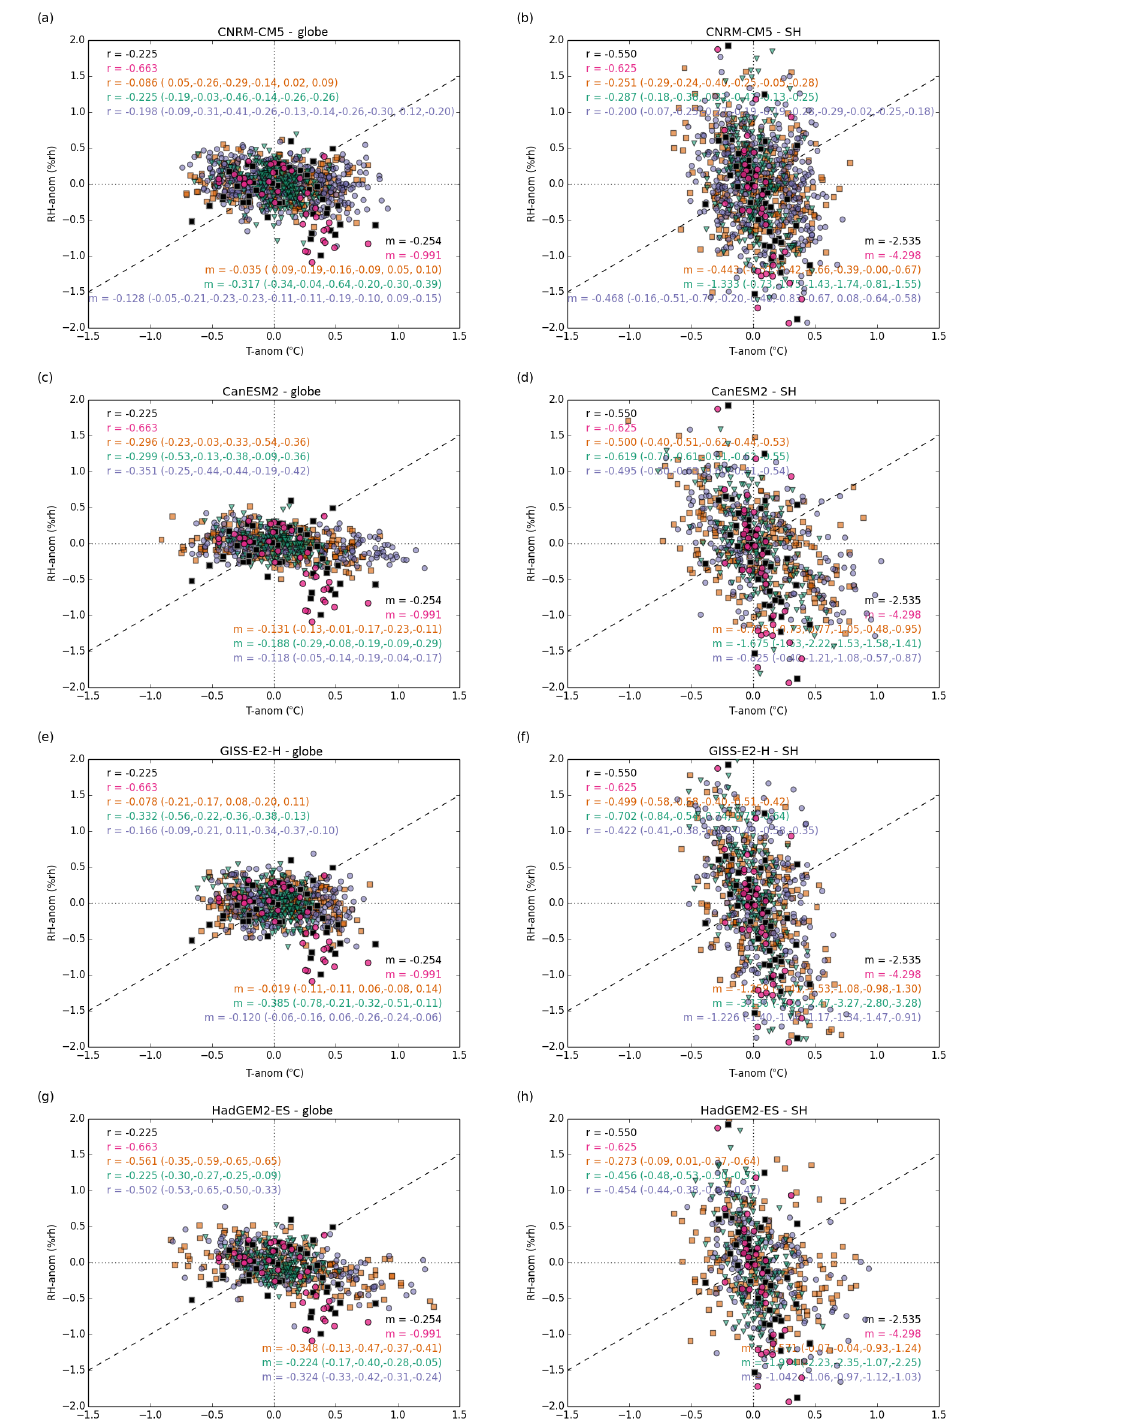
Figure 10. Relationships between temperature and specific humidity for the globe (a, c, e, g) and Southern Hemisphere (b, d, f, h) for a selection of CMIP5 models compared to HadISDH and ERA-Interim. Correlations ( r ) are shown in the top left-hand corner of each panel. The gradient of the line of best fit is given in the bottom right-hand corner of each panel. HadISDH is shown in black. ERA-Interim is shown in magenta. Historical, historicalNat and historicalGHG are shown in purple, green and orange respectively. The ensemble mean value is given for each model with individual member values in